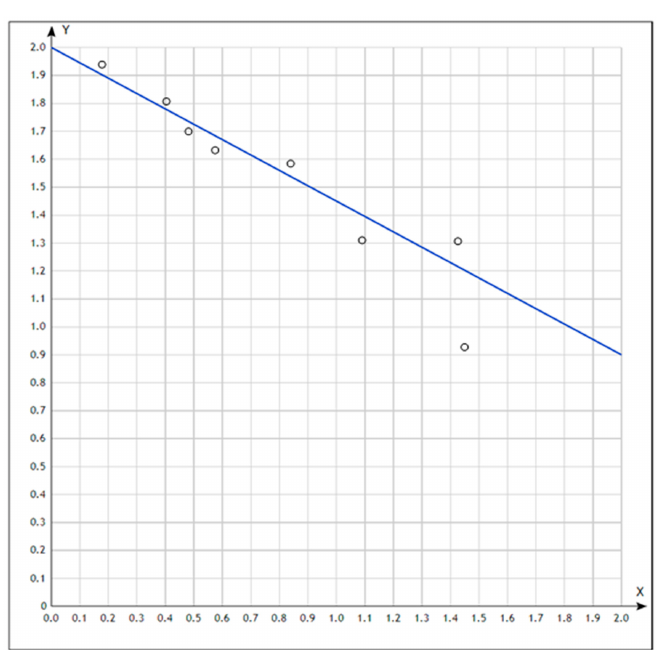
Figure 7. Determination of the similarity dimension for the wind field of the atmosphere in the surface layer.